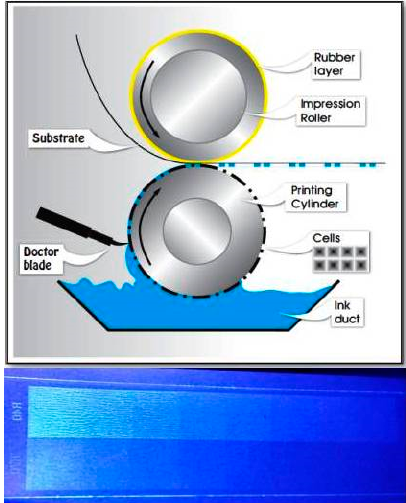
Figure 5. (Upper) Schematic representation of gravure printing technique. (Lower) Paper substrate printed with fluorescent CDs ink, under UV (365nm) light, showing gradient luminescence in accordance to layer thickness.